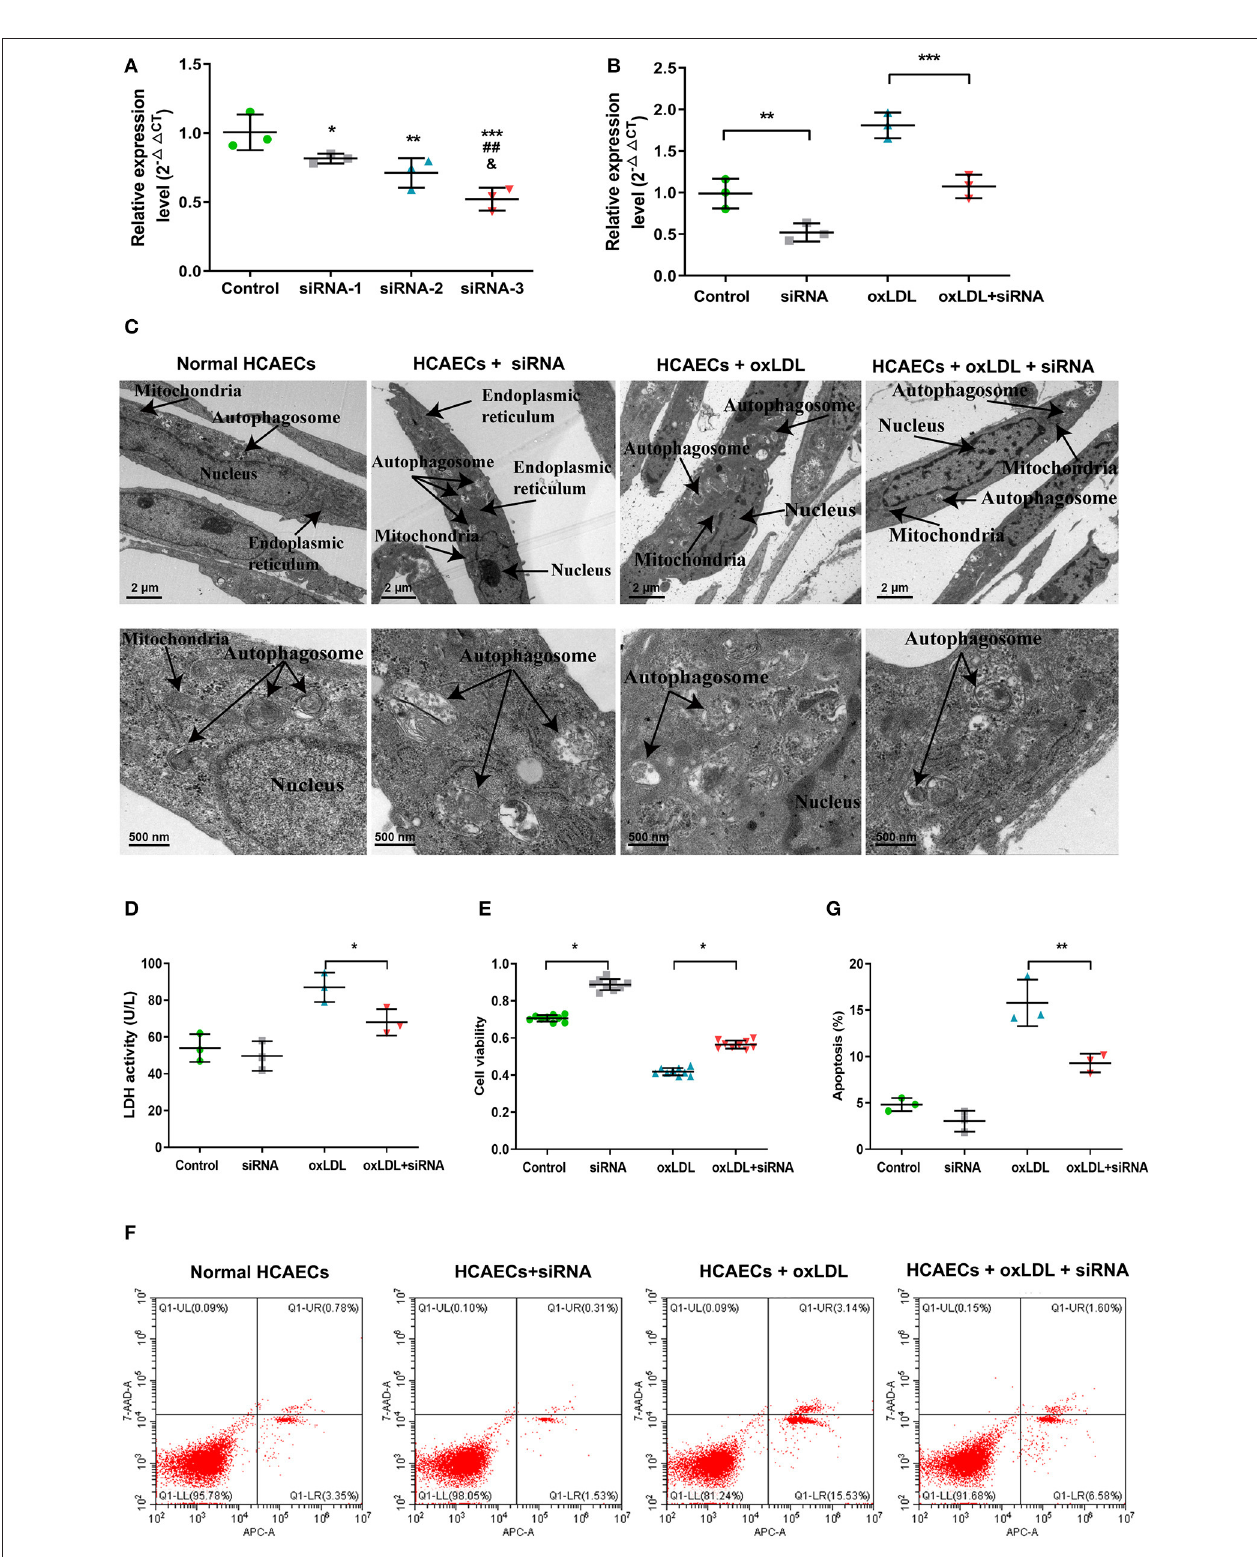
FIGURE 4 | The function of knockdown of lnc-MICALL2-2 in oxLDL-induced HCAECs injury. (A) Lnc-MICALL2-2 interference fragment screening. * p < 0.05, ** p < 0.01, *** p < 0.001 vs. normal HCAECs; ## p < 0.01 vs. HCAECs treated with siRNA-1; & p < 0.05 vs. HCAECs treated with siRNA-2 ( n =